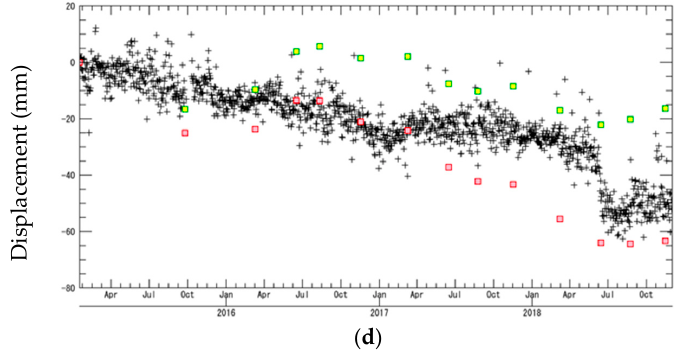
Figure 6. Comparison between the displacement calculated by the small baseline subset (SBAS) method and that obtained from the GEONET data for ( a ) Shiroi, ( b ) Tomisato, ( c ) Ichihara, and ( d ) Chosei. The green and red squares and black crosses represent the SBAS, corrected SBAS, and GEONET data, respectively.